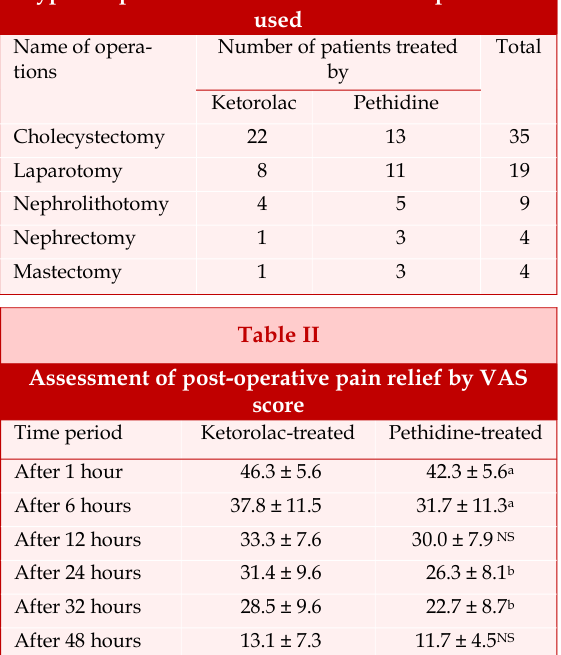
Type of operations where ketorolac and pethidine used